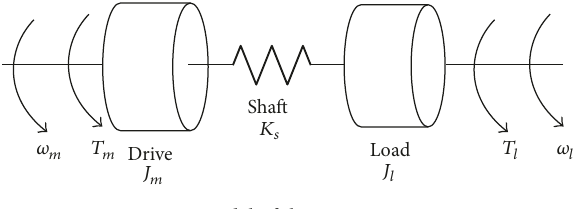
Figure 3: Model of the two-mass system.